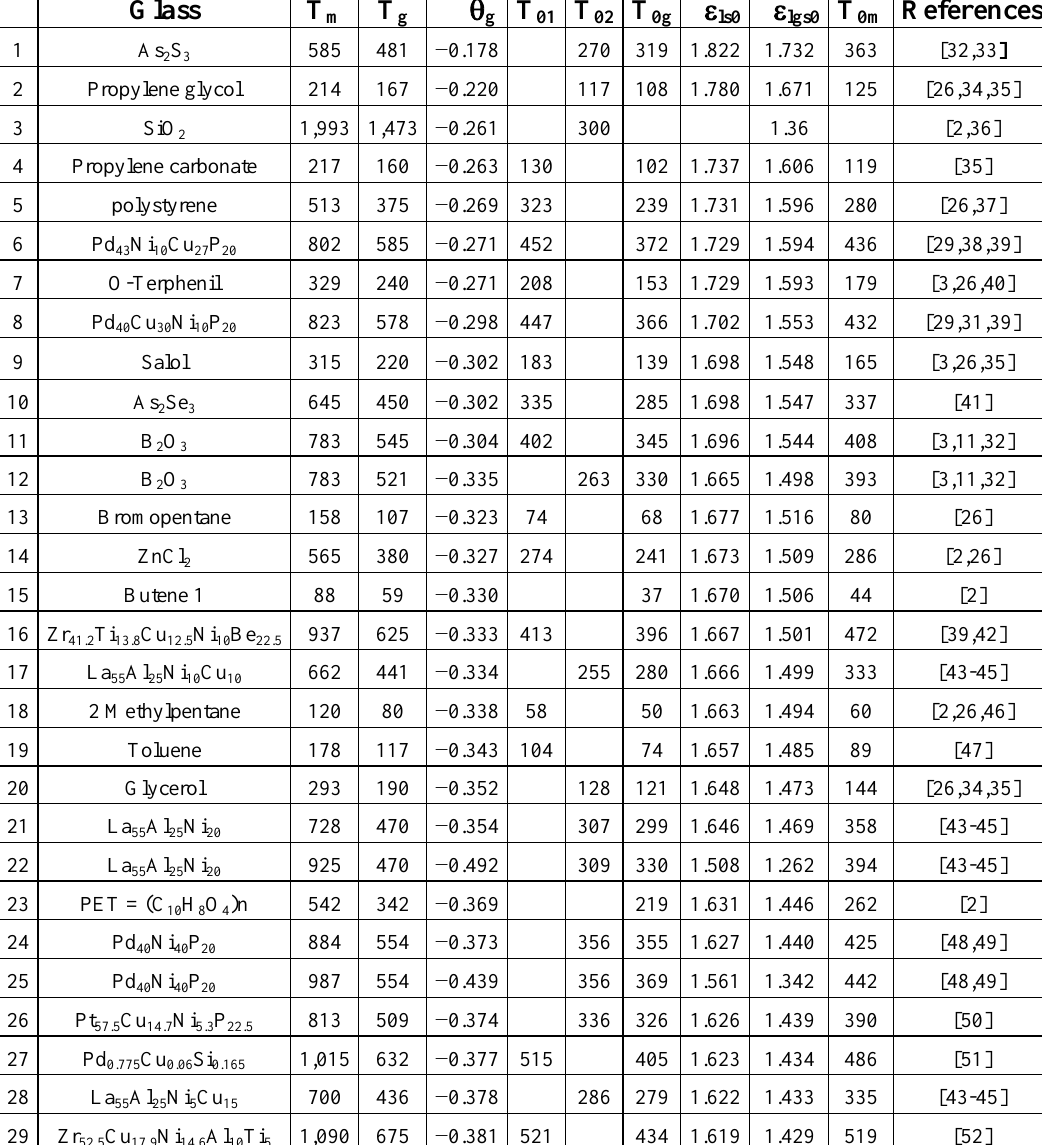
the melting m the vitreous transition temperature,  = (T − T )/T , T and T the g g g m m 01 02 the free-volume 0g and not from T* ;  the energy saving g g ls0 the lgs0 and  ls0 lgs0 and T ; T the free-volume disappearance temperature also 0m 0g 0m and not from T* ; and g g